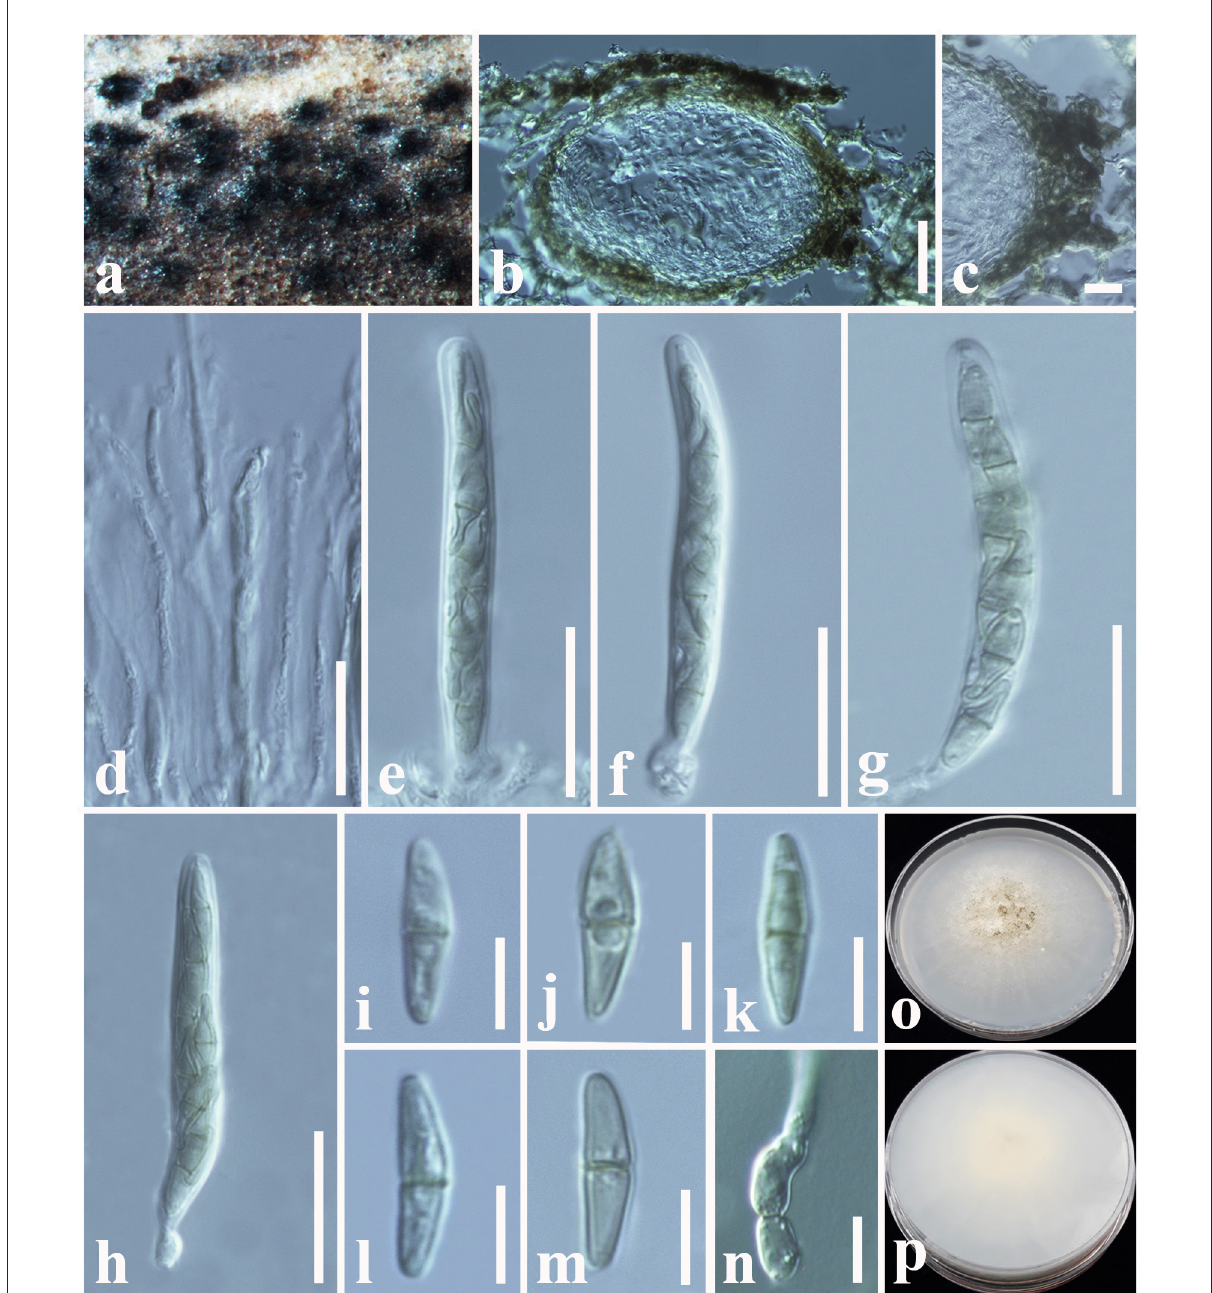
FIGURE8 Paraconiothyrium zingiberacearum (NCYU 19-0320, holotype). (a) Ascomata on a dead stem of Hedychium coronarium . (b) Vertical section through an ascoma. (c) Peridium. (d) Pseudoparaphyses. (e–h) Asci. (i–m) Ascospores. (n) Germinating ascospore. (o) Upper side of the culture. (p) Lower side of the culture. Scale bars: (b) = 50 µ m, (c) = 10 µ m, (d–h) = 20 µ m, (i–n) = 6 µ m.